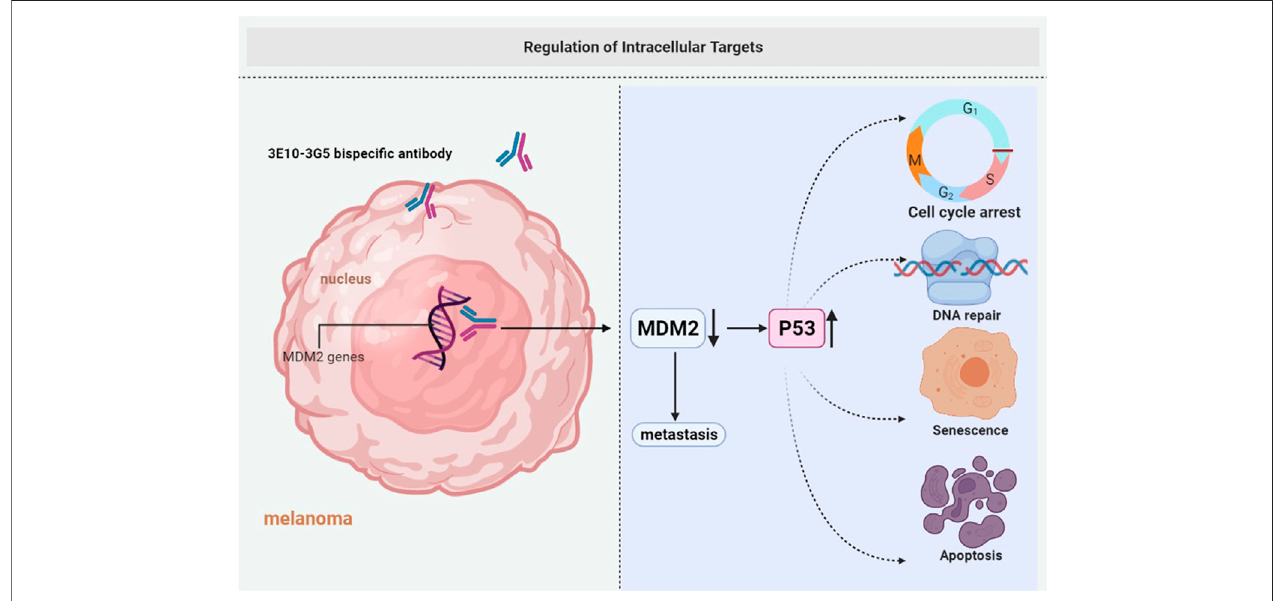
FIGURE 4 | Regulation of intracellular targets. Cell membranes are impermeable to most macromolecules. 3E10-3G5 bispeci fi c antibody retains cell-penetrating and MDM2-binding activities, increases tumor p53 expression, and inhibits the growth of tumors.